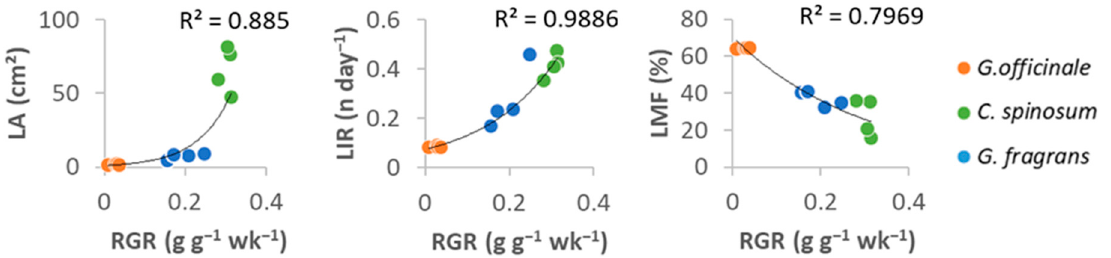
Figure 5. Relationships between relative growth rate (RGR) and leaf initiation rate (LIR), leaf area (LA) and leaf mass fraction (LMF) in seedlings of the three species studied (four individuals per species). See Supplementary Materials Table S2 for Pearson correlation matrix of traits.